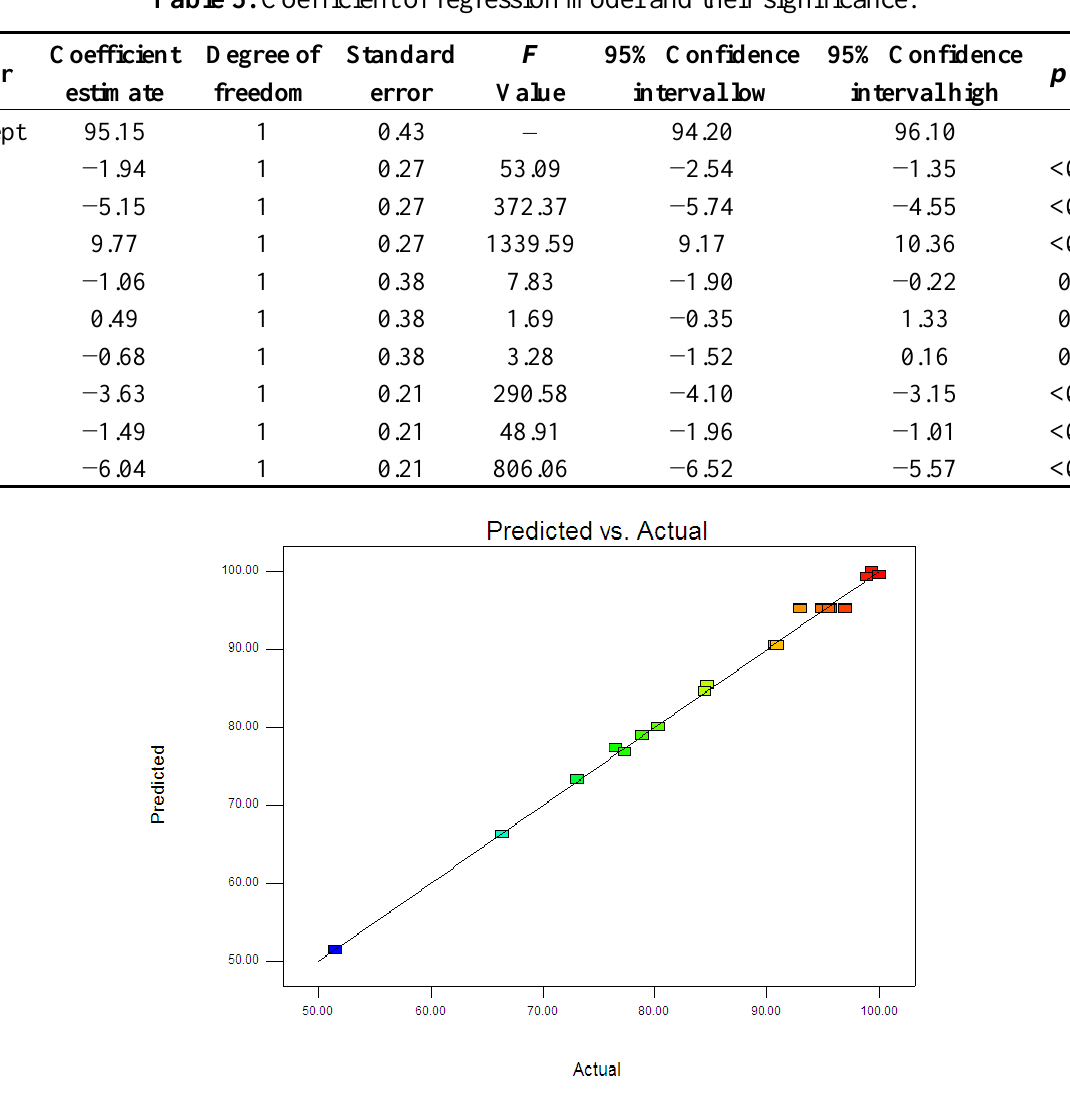
Figure 3. Predicted vs. actual values for photodegradation of